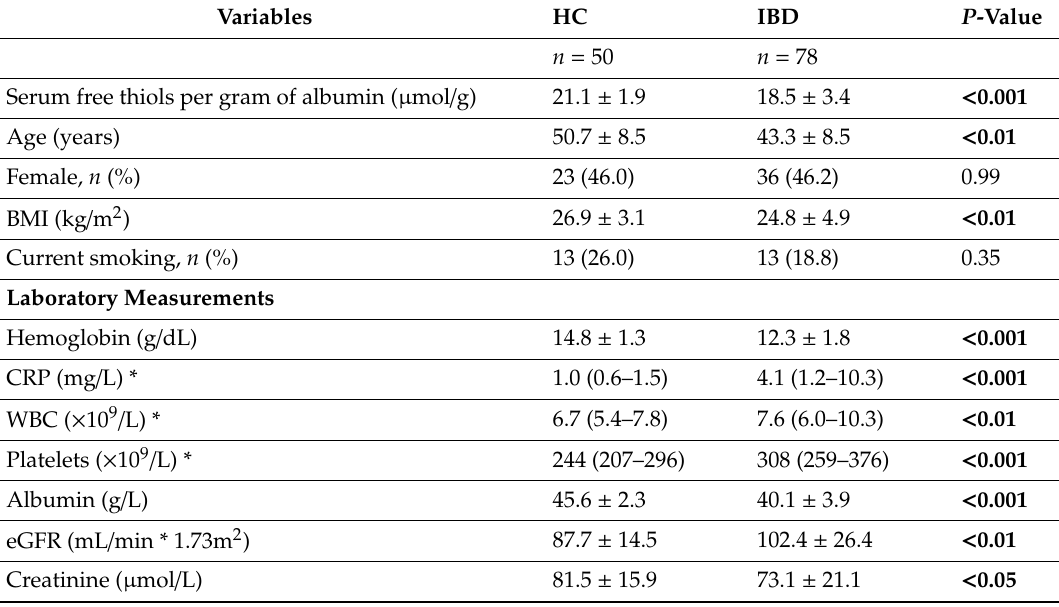
Table 1. Baseline characteristics of IBD patients and healthy controls (HC).